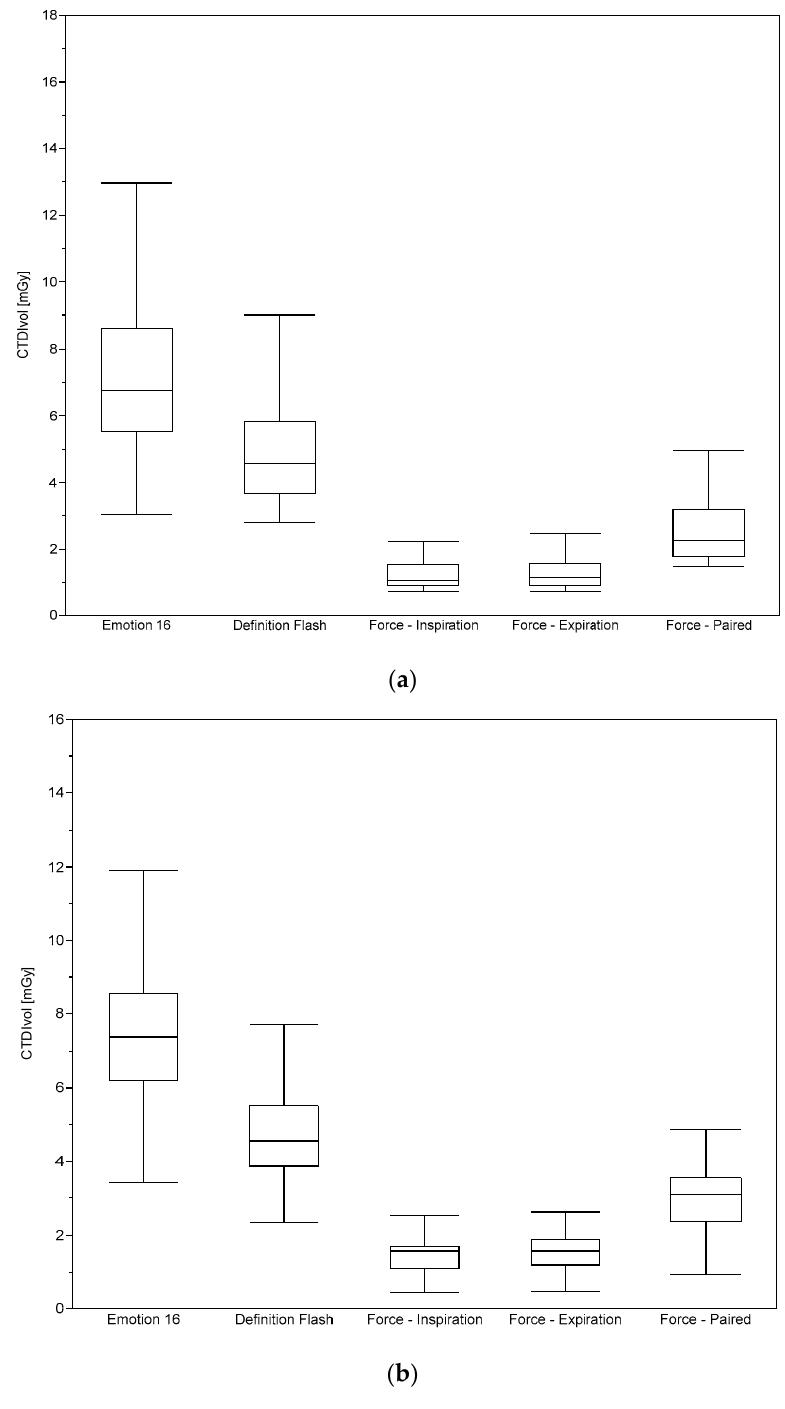
Figure 3. Volume CT dose index (CTDI vol ) evaluated for ( a ) female and ( b ) male patients undergoing chest scans using the five protocols considered.